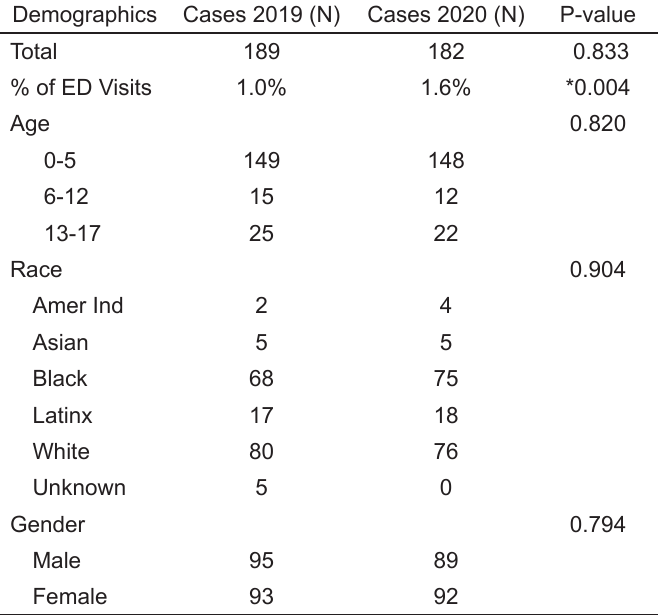
Table 2. Demographic data for patients with a Child Protection Team consult from 2019-2020.